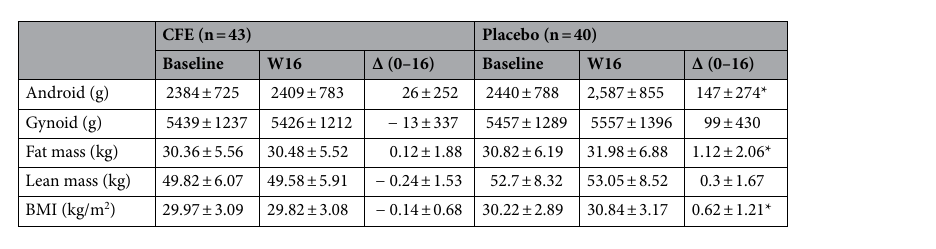
Table 2. Morphology details from DXA scans over 16 weeks of supplementation. Data presented as mean ± SD; CFE, Caralluma fimbriata ; W16, week 16; Δ, change; BMI, body mass index; *significant change between groups at p < 0.05.